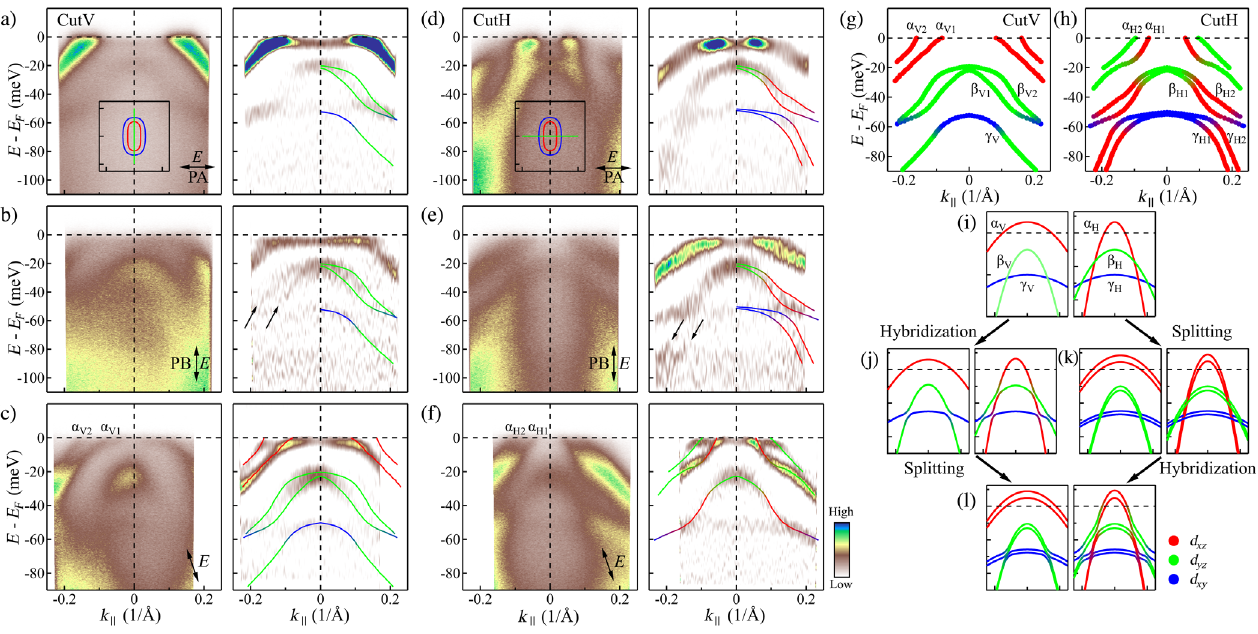
FIG. 3. Band structure of single-domain FeSe along high-symmetry cuts and their orbital nature. (a) – (c) Band structure measured along the vertical momentum cut under PA (a), PB (b), and a mixed (c) polarization geometries. The location of the momentum cut is shown in the inset of (a). The left-hand panels of (a) – (c) represent the original data while the right-hand panels are corresponding second derivative images with respect to energy in order to enhance the contrast. Some observed bands are marked by the guide lines and arrows. (d) – (f) Same as (a) – (c) but for the horizontal momentum cut as marked in the inset of (d). (g),(h) Extracted band structure for the vertical momentum cut (g) and horizontal momentum cut (h) obtained from (a) – (c) and (d) – (f), respectively. The observed bands are labeled as three branches of α , β , and γ . (i) Schematic of the band structure along the vertical (left-hand panel) and horizontal (right-hand panel) momentum cuts from α (red lines), β (green lines), and γ (blue lines) orbitals. (j) Same as (i) but only considering the hybridization between different bands. (k) Same as (i) but only considering the splitting of each band. (l) Same as (i) but considering both band hybridization and splitting of each band. The red, green, and blue colors represent the d xz , d yz , and d xy orbitals,